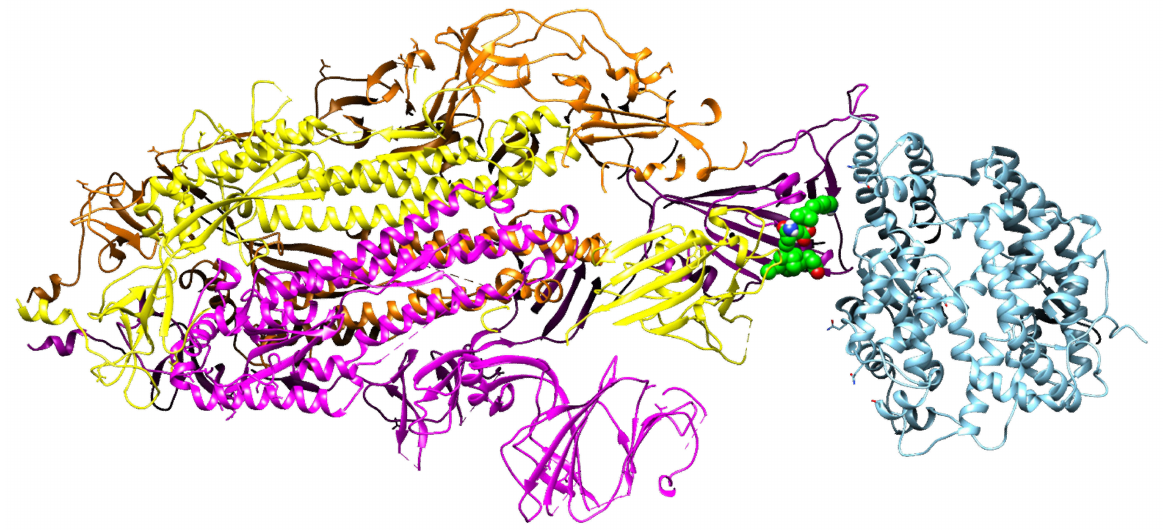
Figure 5. Schematic representation demonstrating bromelain peptide (green) inhibiting RBD (yellow) adhesion to hACE2 (light